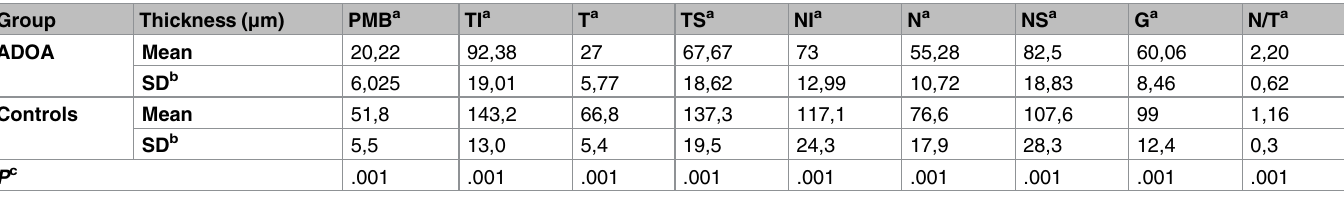
were significantly increased in the ADOA group ( P = 0.001). Table 3. Peripapillary RNFL thickness values provided by RNFL-N Axonal Analytics and Statistical Differencesin Autosomal-Dominant Optic Atrophy (ADOA) and Control Subjects.